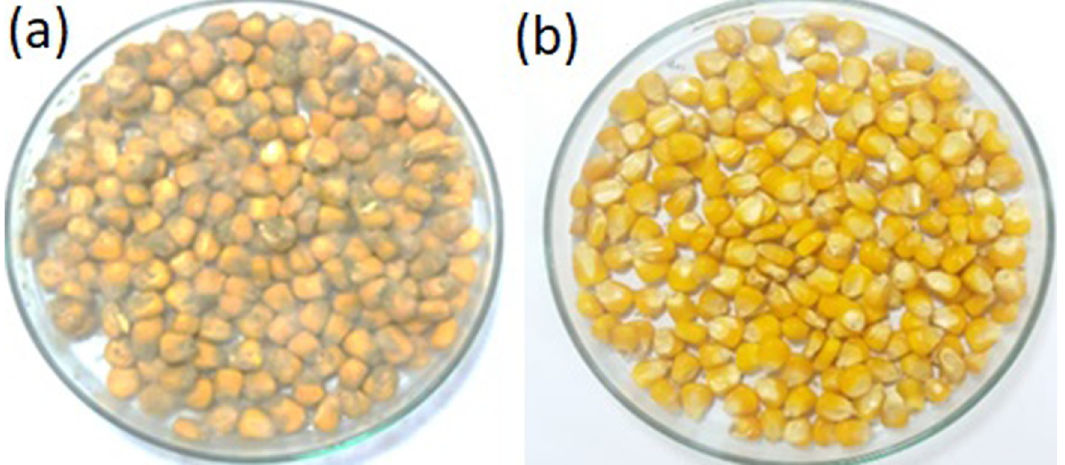
Fig 2. Aspergillus flavus growth on to maize grains. (a) treated with MRS broth (control) and (b) treated with CFS of Loig . coryniformis BCH-4 incubated at